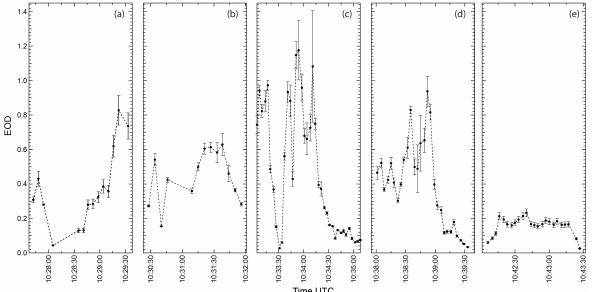
Fig. 4. Time evolution of the fire smoke plume effective optical depth (EOD) deduced from (a) scan 1, (b) scan 2, (c) scan 3, (d) scan 4, and (e) scan